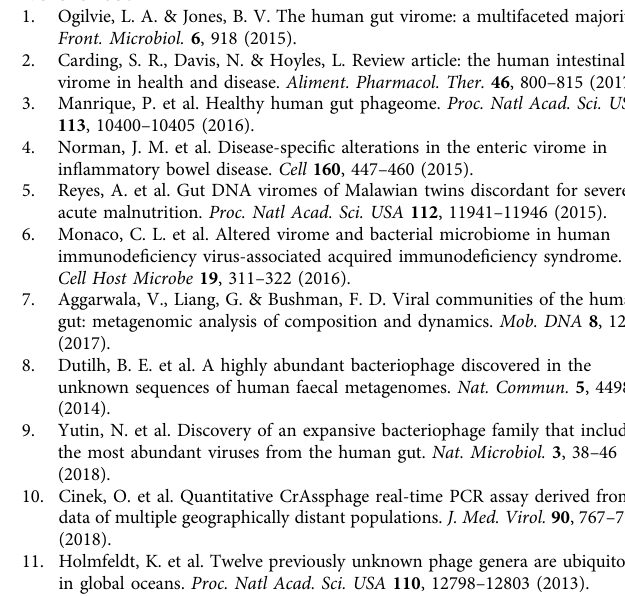
Supplementary Figure 2. The PCR primers Φ crAss001-F1 (5 ′ -AATAAGGTGGAAGATGCTGAC-3 ′ ) and Φ crAss001-R1 (5 ′ -TTATCCATTTGGTCAACAGCTC-3 ′ ), speci fi c towards gene 20 (portal protein) of Φ crAss001 were developed for detection and quanti fi cation of the phage in cultures of B. intestinalis